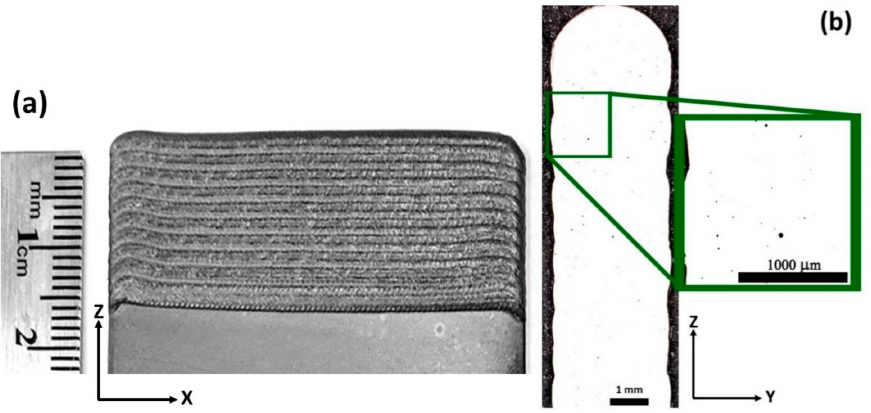
Figure 3. ( a ) A multi-layer 4275M72 deposition on an H230 substrate using LDED, and ( b ) polished cross-section of deposited layers showing